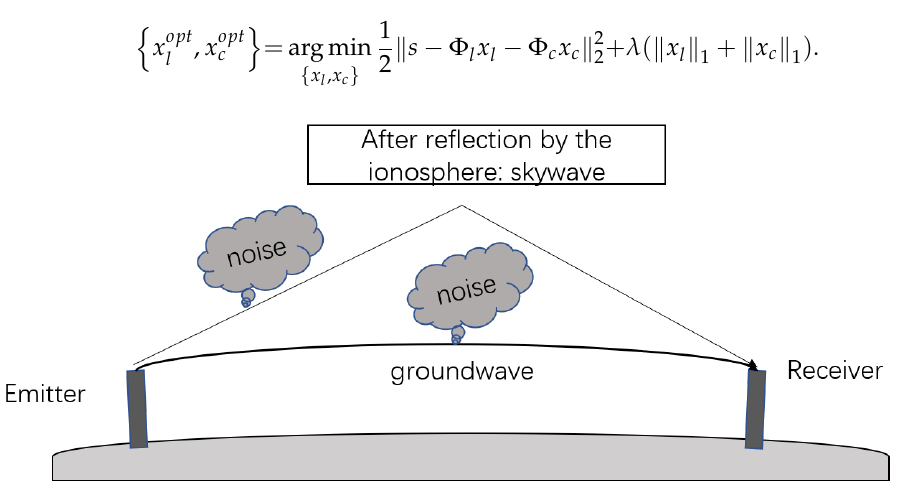
Figure 2. The propagation of skywave and groundwave.